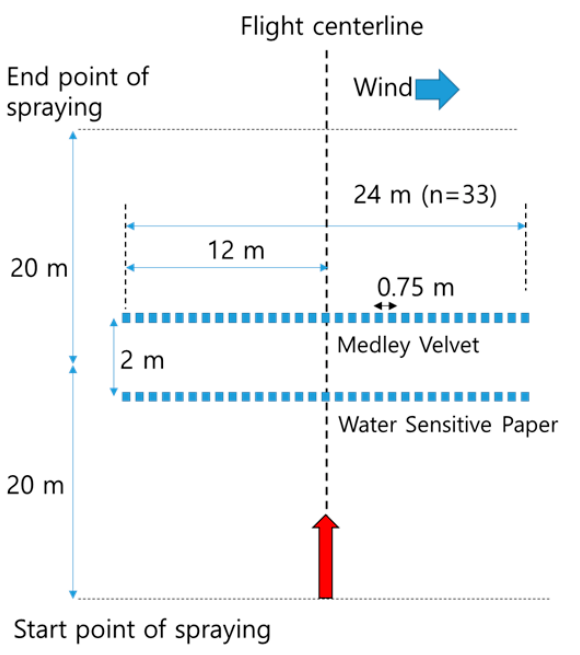
Figure 5. Layout of spray deposition test.